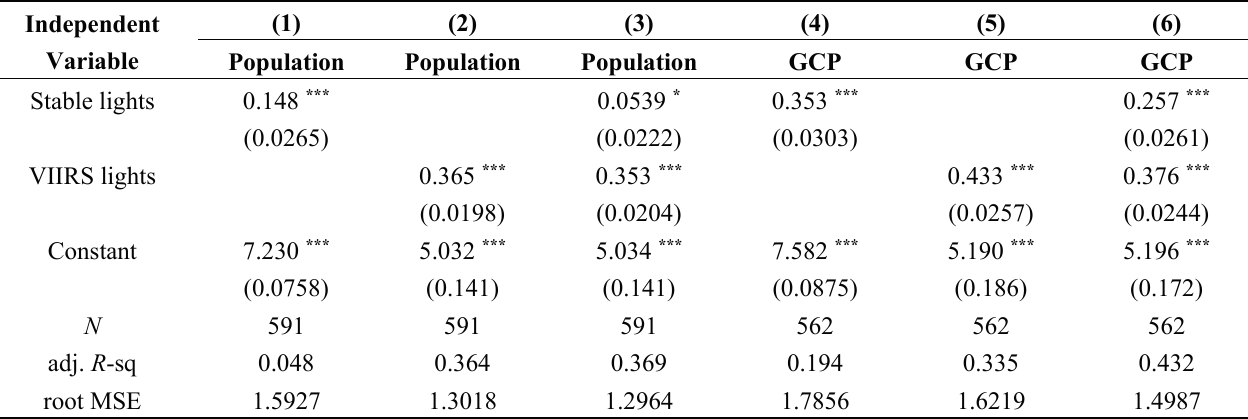
Table 8. Operational Linescan System (OLS) regression for cells with population less than